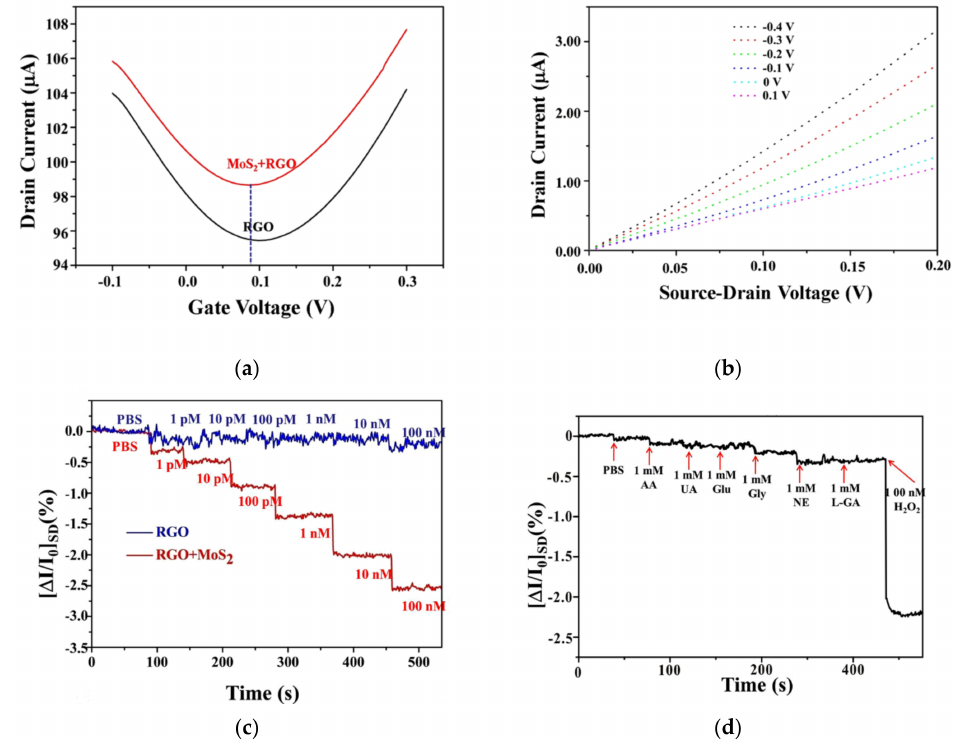
Figure 5. MoS 2 /RGO FET for detecting H 2 O 2 , ( a ) Transfer characteristics for MoS s /RGO FET, Drain current versus gate voltage for MoS 2 /RGO and RGO FETs ( b ) Drain current versus source-drain voltage for MoS 2 /RGO, ( c ) The change in drain-source current for different concentrations of H 2 O 2 ( d ) Negligible current change for different interferents (PBS, 1 mM AA, 1 mM UA, 1 mM Glu, 1 mM GLY, 1 mM NE, 1 mM L-GA) and a noticeable change for H 2 O 2 . Adapted from [86]. Springer Nature